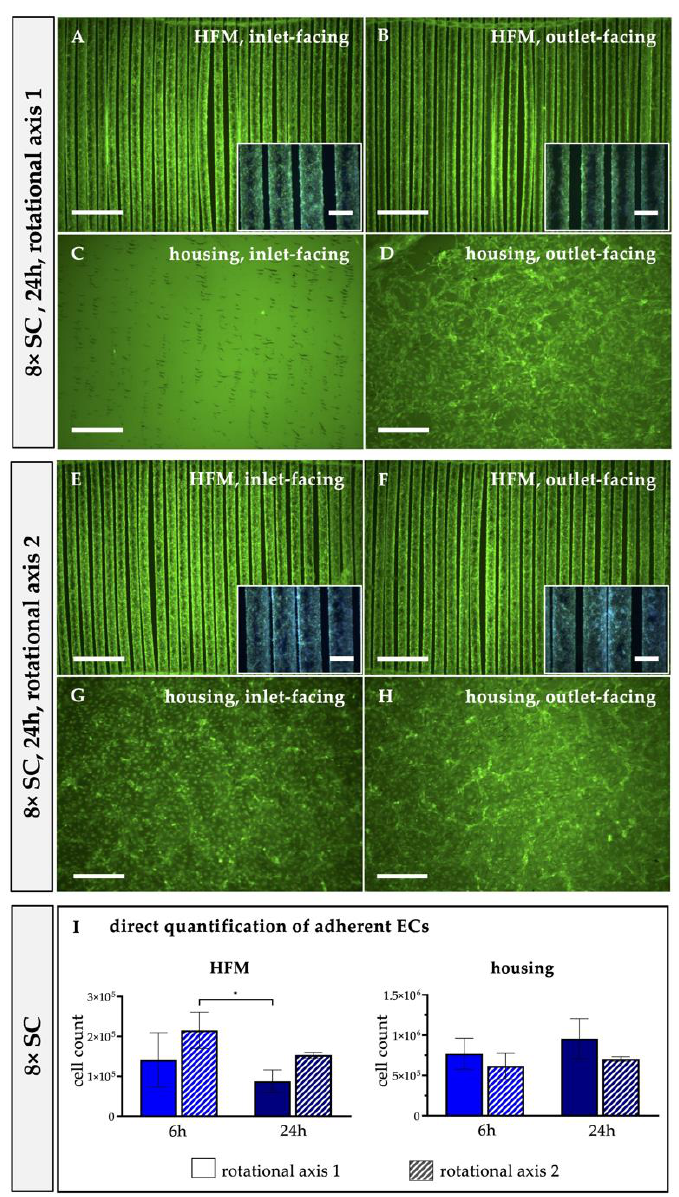
Figure 4. Twenty-four hour seeding procedure succeeded in complete MOx endothelialization when 8 × SC and RA2 were applied. Following staining with calcein (green) and Hoechst 33342 (blue), fluorescence microscopy images were taken from HFMs ( A , B , E , F ) and the housing ( C , D , G , H ), facing the inlet ( A , C , E , G ) and outlet ( B , D , F , H ), after seeding with 8 × SC for 24 h and applying RA1 ( A – D ) or RA2 ( E – H ). Scale: 2 mm, insert boxes in A, B, E, F, scale: 400 µm. ( I ) Direct quantification of adherent ECs on HFMs and housing after seeding procedure using 8 × SC for 6 h vs. 24 h with RA1 vs. RA2. SC: seeding concentration, RA: rotational axis. * p < 0.05.